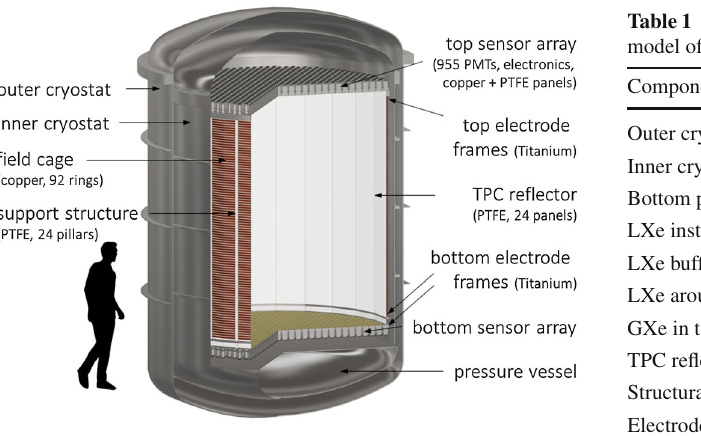
Fig. 1 DrawingofDARWIN’sdouble-walledcryostatandTPC,show- ing all components considered in the simulation